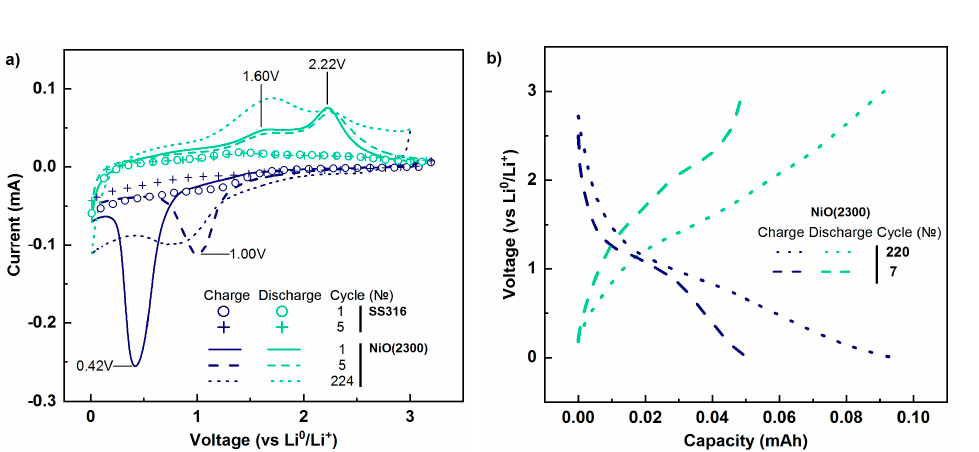
Figure 7. Cyclic voltammograms of stainless steel 316SS and stainless steel with NiO film ( a ), and charge / discharge curves of stainless steel with NiO film ( b ).